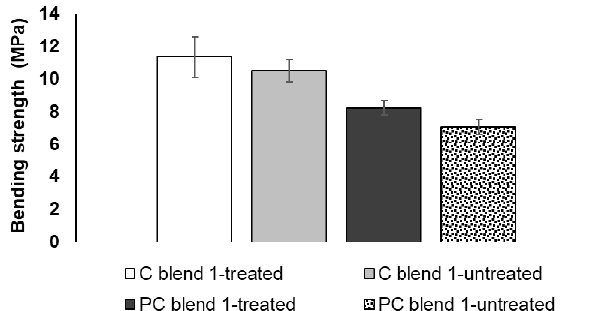
Figure 9. Tensile strength of treated and untreated cotton and polycotton blends.